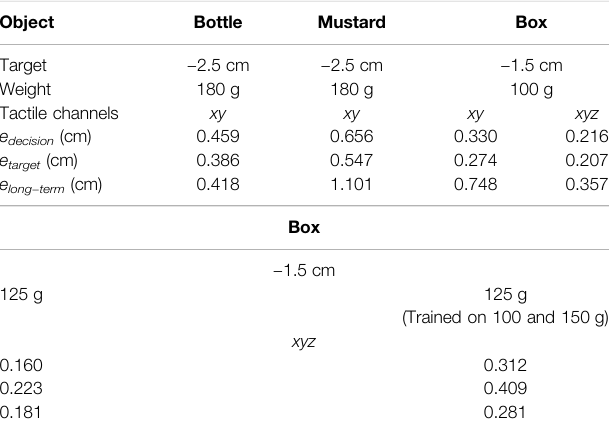
TABLE 6 | Decision, target and long-term errors for several objects with different weights, several targets and con fi gurations of the tactile channels. Object Bottle Mustard